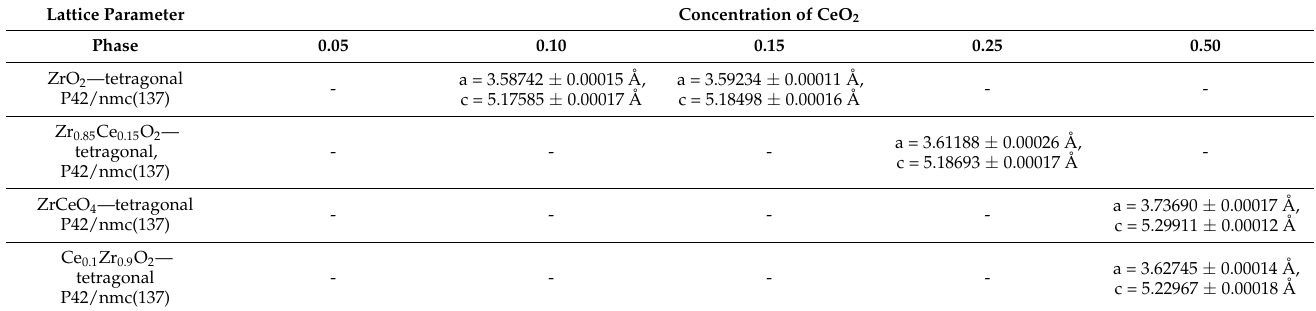
Figure 5. Results of the change in the hardness of ceramics depending on the CeO 2 concentration.